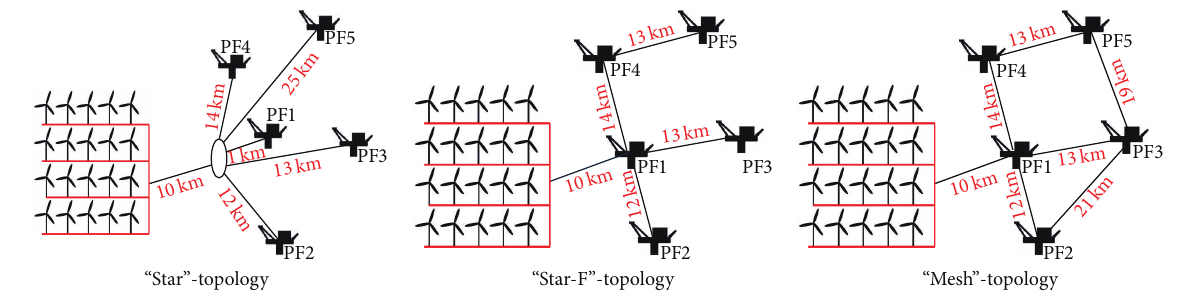
Figure 4: Three different interconnections of the five